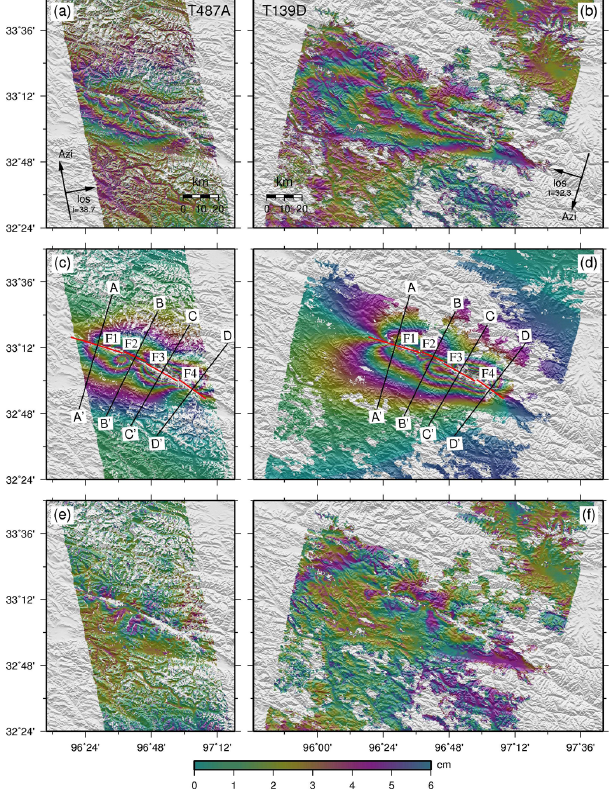
Fig. 3. Ascending track 487 strip mode interferogram after trend re- moval and rewrapped to 6cm fringes (a) , simulated interferogram (c) and residual (e) based upon the four fault segments (red lines) slip distribution. Descending track 139 wide-swath mode interfer- ogram after trend removal and rewrapped to 6cm fringes (b) , sim- ulated interferogram (d) and residual (f) based upon the four fault segments slip distribution. The black lines AA 0 , BB 0 , CC 0 and DD 0 are profiles used in Fig.